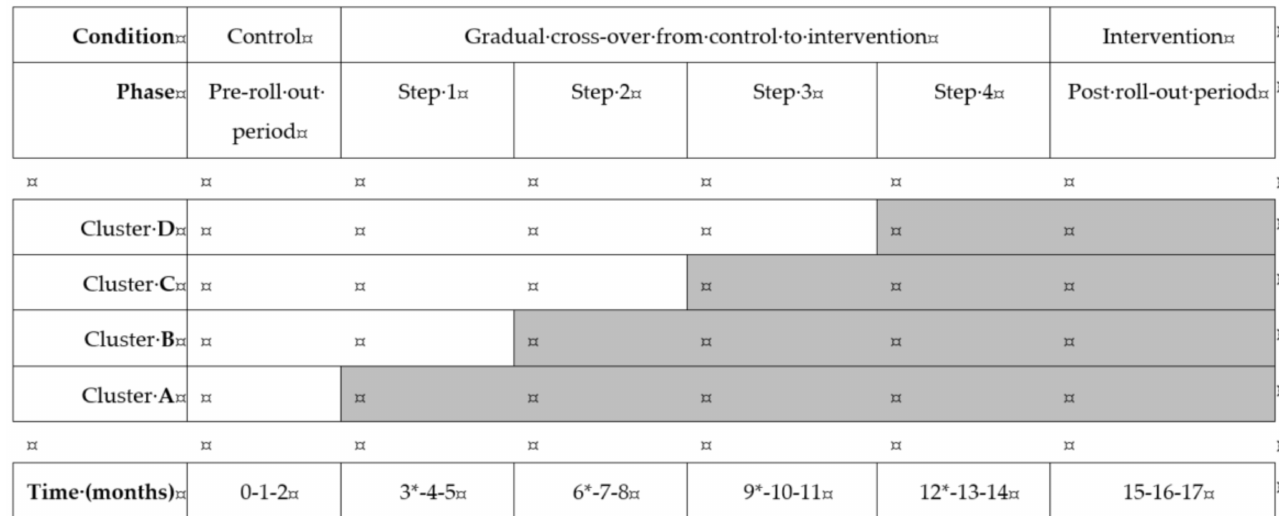
Figure 1. Schematic overview of the stepped-wedge study design. All clusters started in the control condition in the pre-roll out period (3 months). Clusters A-B-C-D then gradually crossed-over to the intervention condition after 3, 6, 9 and 12 months, respectively (*). Women were followed throughout pregnancy until birth. Outcome data collection continued until 6 months after the last inclusion during the post roll-out